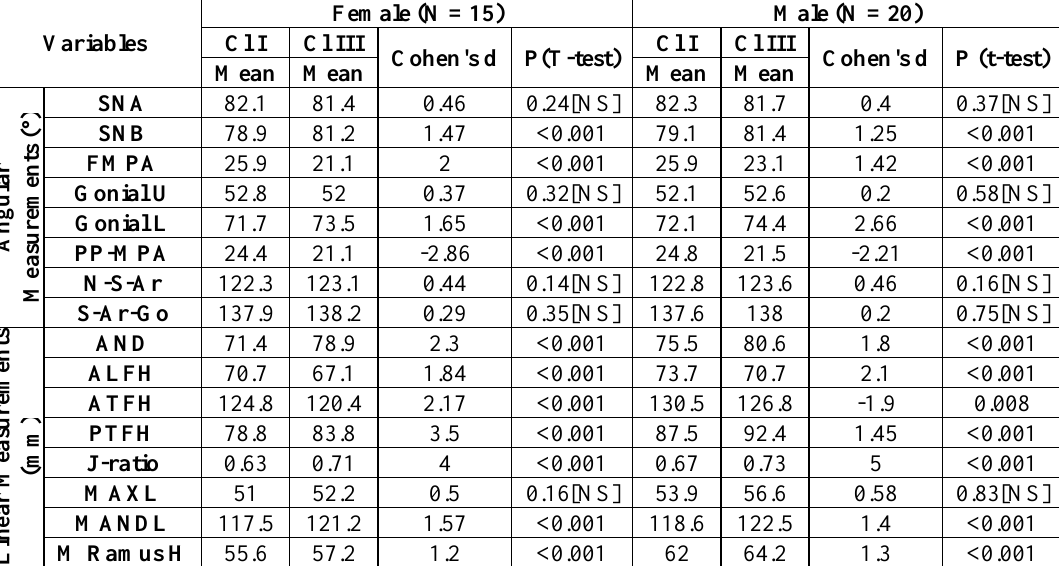
Table 1: Difference between Skeletal Class I and Class III Relationships in Selected Measurements Stratified by Gender